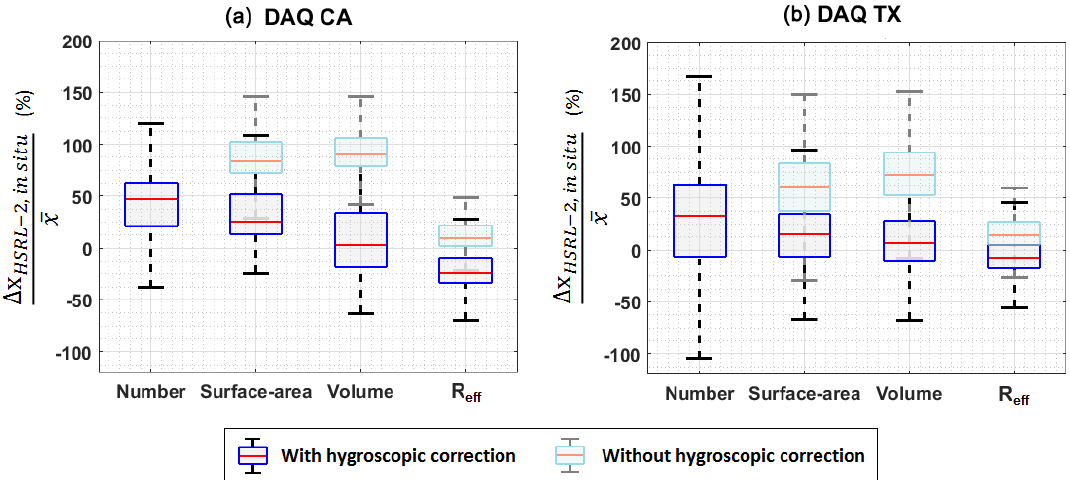
Figure 7. Statistics of the comparison between the HSRL-2 retrievals and the in situ measurements of number, surface-area, and volume concentrations, and effective radii for DAQ CA (a) and DAQ TX (b) with and without the hygroscopic correction applied to the in situ measurements (fine-mode only). The box plots represent the distribution of the biases observed between the HSRL-2 retrievals and the in situ measurements for each parameter. The relative bias was calculated as the ratio of the difference between HSRL-2 retrievals and the in situ measurements ( (cid:49)x ) to the average between the HSRL-2 retrievals and the in situ measurements ( x ). The red line represents the median value, the boxes edges represent the 25th and 75th percentiles ( q 1 , q 3 , respectively), and the whiskers represent the outlier boundaries ( q 1 − 1 . 5 × IQR) and ( q 1 + 1 . 5 × IQR), where IQR is the interquartile range, defined as IQR = q 3 − q 1